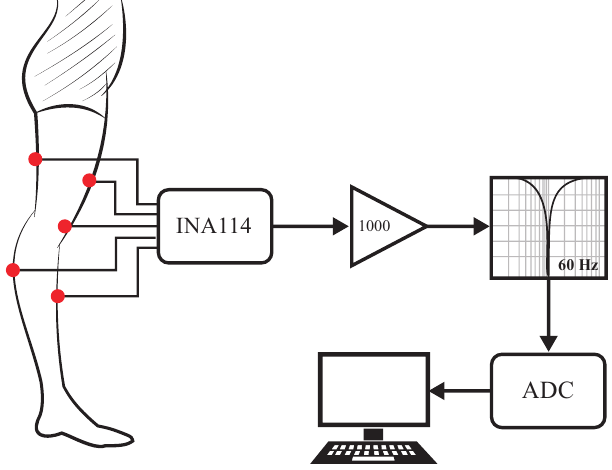
Figure 1. Basic experiment